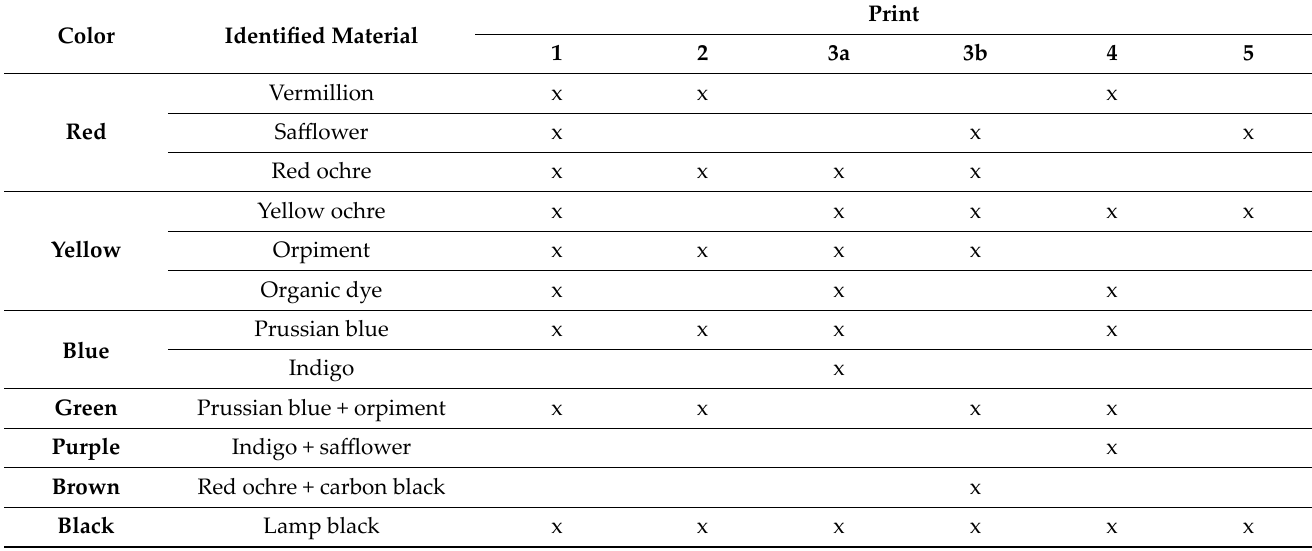
Table 3. Coloring materials identified in the six woodblock prints by Utagawa Kunisada examined in the present